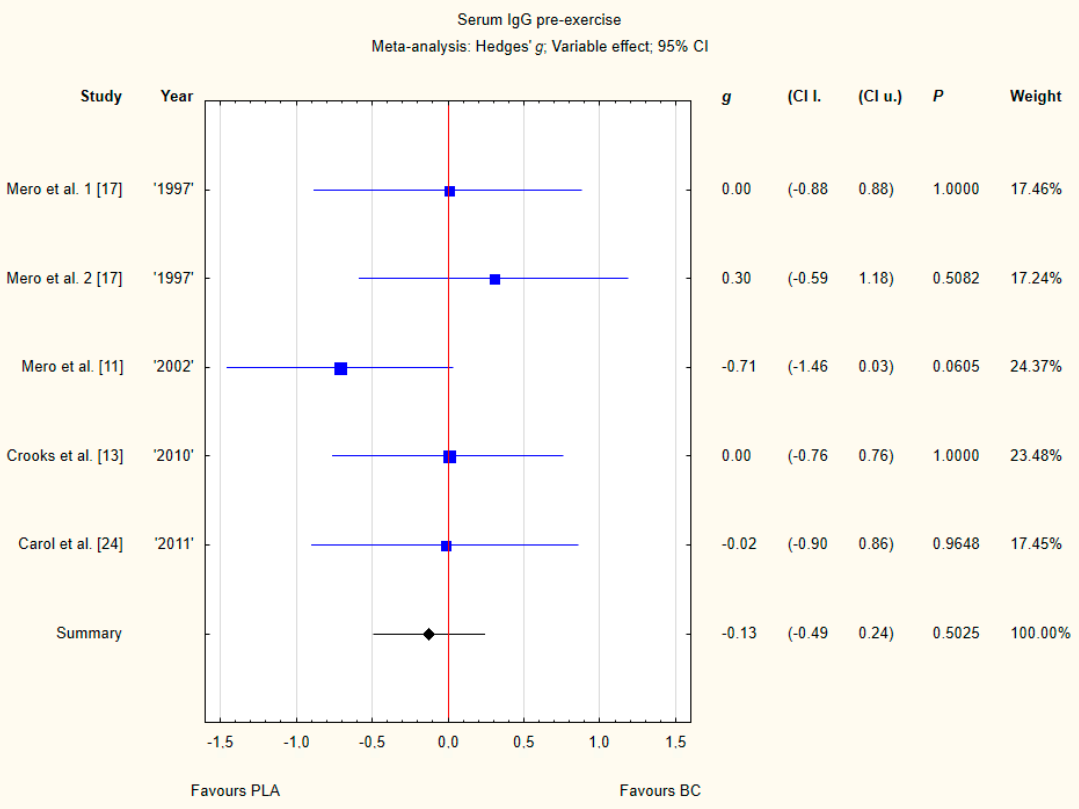
Figure 7. Forest plot of the random-effects meta-analysis of changes in IgG concentration. Heterogeneity: Tau 2 = 0; Chi 2 = 3.51; df = 4; I 2 = 0%; P = 0.4756. 1–the first dose from Mero et al. [17]